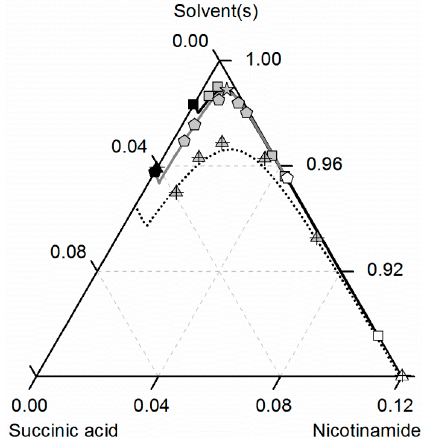
Figure 7. Solubilities of nicotinamide (NA) and succinic acid (SA) and the corresponding 2:1 cocrystal (CC) in ethanol (pentagons, gray solid lines), water (squares, black solid lines) and an ethanol/water mixture 0.5/0.5 w / w (crossed triangles, black dotted lines) at 298.15 K with shortened axes in mole fractions. Lines correspond to the PC-SAFT calculations; symbols refer to the experimental data points of SA (black), the CC (gray) and NA (white). The star is the CC solubility point used for the solubility product (cid:1837) (cid:3046) . The CC lines in ethanol and the ethanol/water mixture were fully predicted.